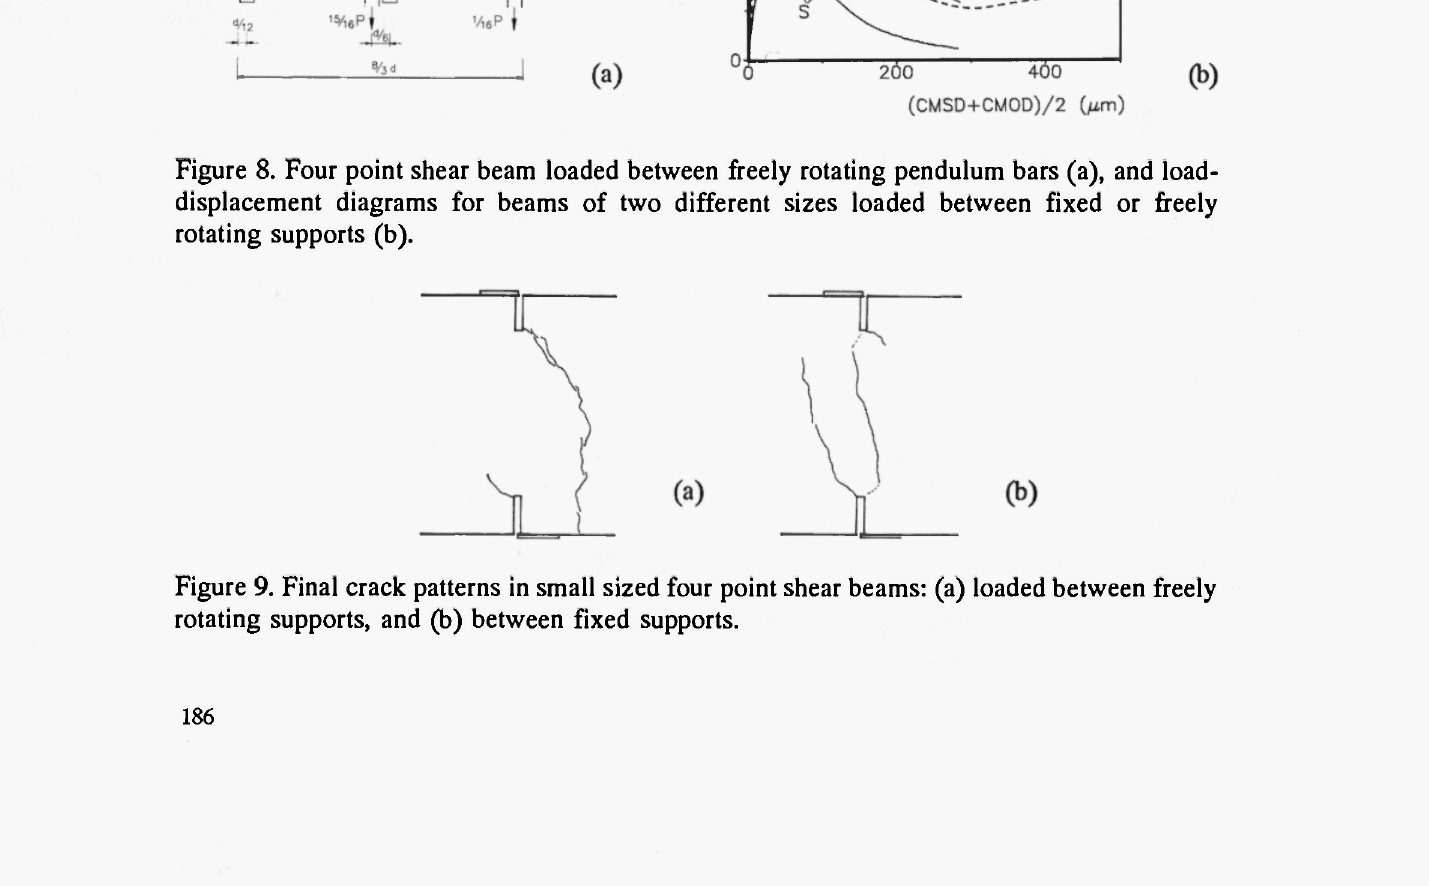
Figure 8. Four point shear beam loaded between freely rotating pendulum bars (a), and load- displacement diagrams for beams of two different sizes loaded between fixed or freely rotating supports (b).